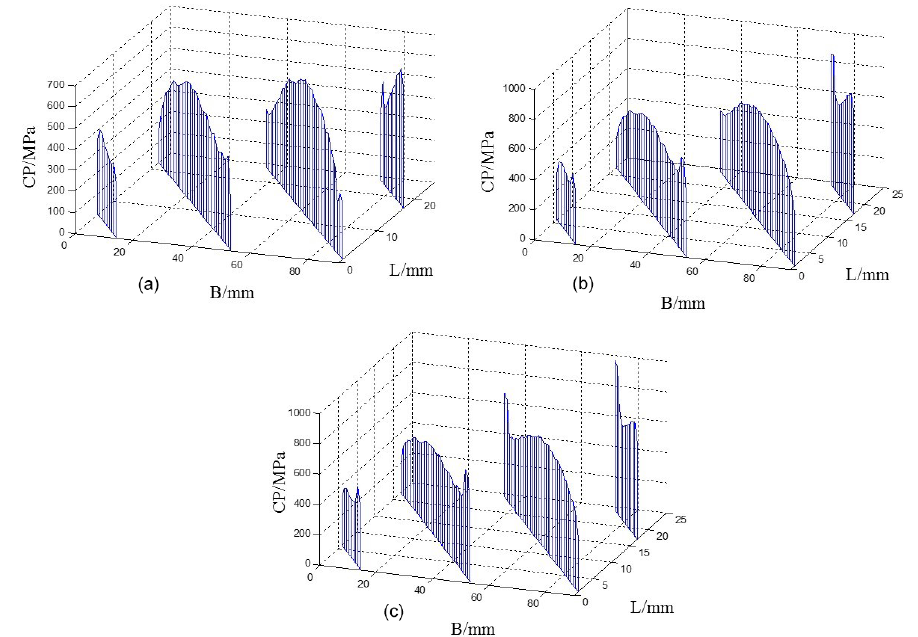
Figure 25. Contact stress distribution of the right tooth surface with the three different modifications of the no. 2 shaft section stiffness. (a) Maximum amount of modification at 37µm. (b) Maximum amount of modification at 28.5µm. (c) Maximum amount of modification at